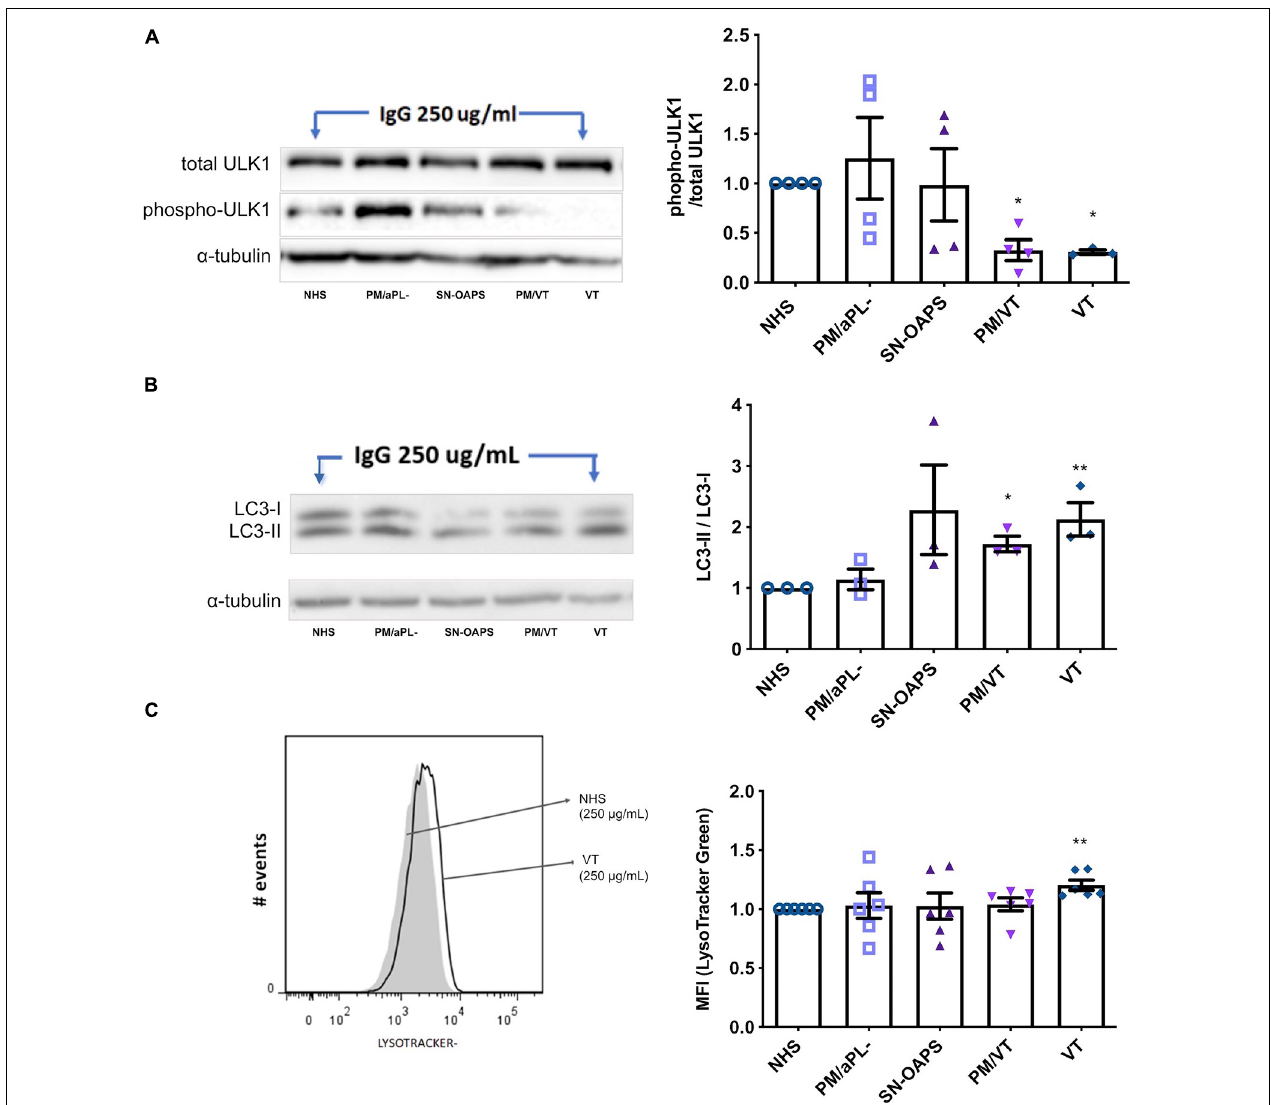
FIGURE 3 | Autophagy is activated by aPL in endothelial cells. HUVECs were stimulated with polyclonal IgG (250 µ g/ml) from women with clinical features of APS (SN-OAPS; PM/VT; and VT) and control groups (NHS and PM/aPL-). (A,B) The early autophagy marker ULK1 and the late autophagy marker LC3-I/LC3-II were evaluated by Western blot. (A) Representative blot for phosphorylated and total ULK1. The chart shows the phospho/total ULK1 ratio. PM/VT and VT IgG significantly reduced ULK1 phosphorylation in comparison with NHS IgG ( n = 4; * p < 0.05 vs. NHS as determined by one-way ANOVA and Dunn’s post-test). (B) Representative blot for LC3-I and LC3-II. The chart shows the LC3-II-LC3-I ratio. PM/VT and VT IgG significantly increased the LC3-II-LC3-I ratio in comparison with NHS IgG ( n = 3; * p < 0.05 and ** p < 0.01 vs. NHS as determined by one-way ANOVA and Holm-Sidak’s post-test). (C) To evaluate autophagy at a functional level, lysosomal acidification was assessed using LisoTracker Green and flow cytometric analysis. Representative histogram showing HUVECs treated with NHS IgG and VT IgG. The chart shows the levels of LisoTracker Green as median fluorescence intensity (MFI) and that treatment of HUVECs with VT IgG significantly increased lysosomal acidification. n = 6; ** p < 0.01 vs. NHS as determined by one-way ANOVA and Dunn’s